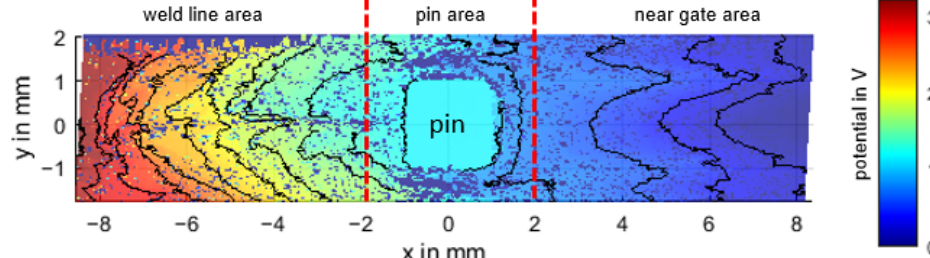
Figure 11. Potential field of the specimen PC CF20_4 mm with equipotential lines (potential difference between the lines is 0.2 V). The top left area is outside of the sample.